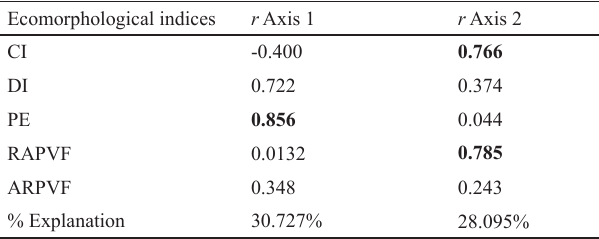
Fig. 2. Principal Components Analysis (PCA) for the six ecomorphological indices related to locomotion in the 19 fish species collected from tide pools on the Amazonian Coastal Zone in 2011. Hypotheses concerning the interpretation of the ecomorpho - logical indices highly correlated with the principal axes. Codes: Atherinella cf. brasiliensis (ABR); Amphichthys cryptocentrus (ACR); Amphiarius phrygiatus (APH); Bathygobius soporator (BSO); Batrachoides surinamensis (BSU); Butis koilomatodon (BKO); Colomesus psittacus (CPS); Epinephelus itajara (EIT); Engraulidae gen. (ENG); Gobiesox barbatulus (GBA); Gym- nothorax aff. funebris (GFU); Lutjanus jocu (LJO); Mugil aff. curema (MCU); Mugil aff. hospes (MHO); Mugil sp. (MSP); Omobranchus punctatus (OPU); Rypticus randalli (RRA); Sphoeroides greeleyi (SGR); Thalassophryne nattereri (TNA). Table 4. Pearson correlation coefficients ( r ) obtained for the first two axes of the Principal Components Analysis (PCA) for the five ecomorphological indices related to the position of the 19 species in the water column. The indices with the highest correlation coefficients (shown in bold type) were selected for interpretation. Codes: Compression index (CI); Depression index (DI); Position of the eye (PE); Relative area of the pelvic.fin (RAPVF); Aspect ratio of the pectoral fin